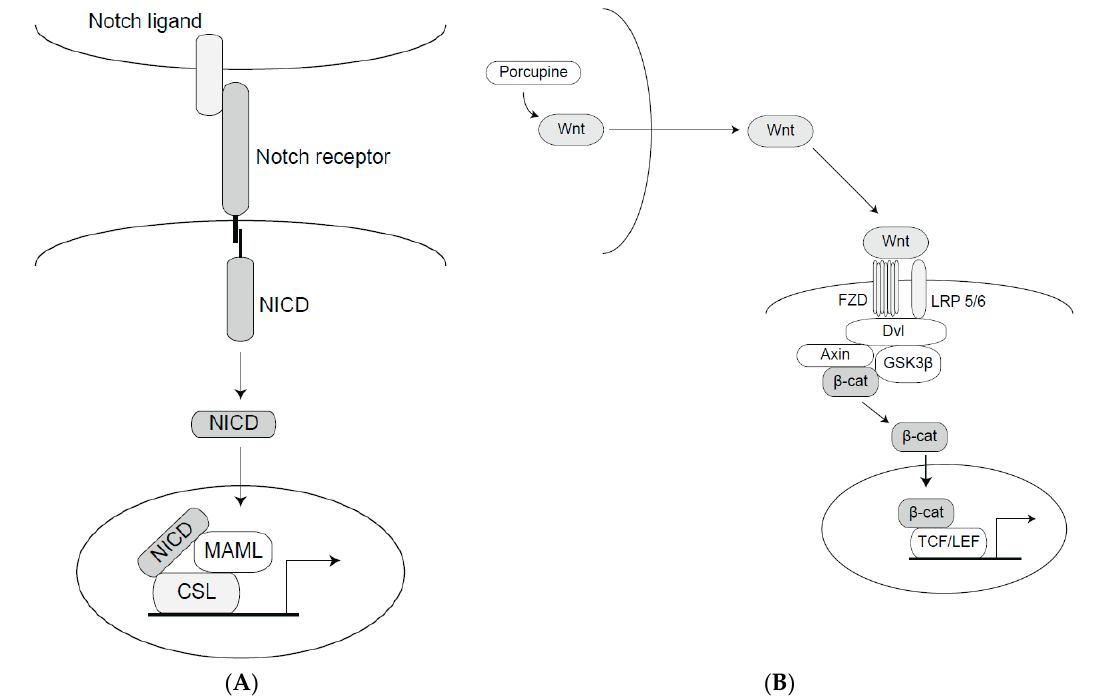
Figure 1. The Notch and Wnt signaling pathways. ( A ) The Notch pathway. A schematic depiction of the proteins in the core Notch signaling pathway. Upon ligand-receptor interaction, the Notch intracellular domain (NICD) is released and forms a ternary complex with MAML and CSL (a DNA-binding protein) in the nucleus to control downstream gene activation. ( B ) The canonical Wnt pathway. The Wnt ligand is modified by porcupine in the ligand-producing cells and interacts with the Frizzled (FZD) receptor. The ligand-activated FZD and Low Density Lipoprotein Receptor-related Protein (LRP5/6) receptors downregulate the activity of the destruction (Dishevelled (Dvl)/Axin/Glycogen synthase kinase 3 β (GSK3 β )) complex, leading to accumulation of β -catenin ( β -cat), and its localization to the cell nucleus. In the nucleus, β -catenin cooperates with T-Cell factor/lymphoid enhancer factor (TCF/LEF) to regulate gene expression.